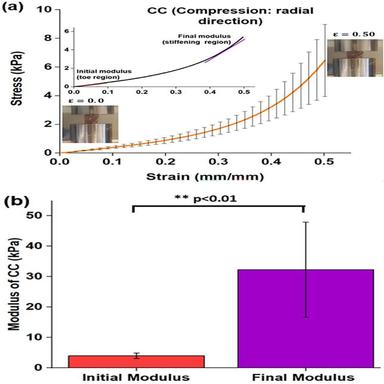
(a) CC tested in compression in radial direction up to a strain level of ε = 0.50 exhibiting the strain-stiffening response at higher strain (b) The initial and final modulus of the CC.